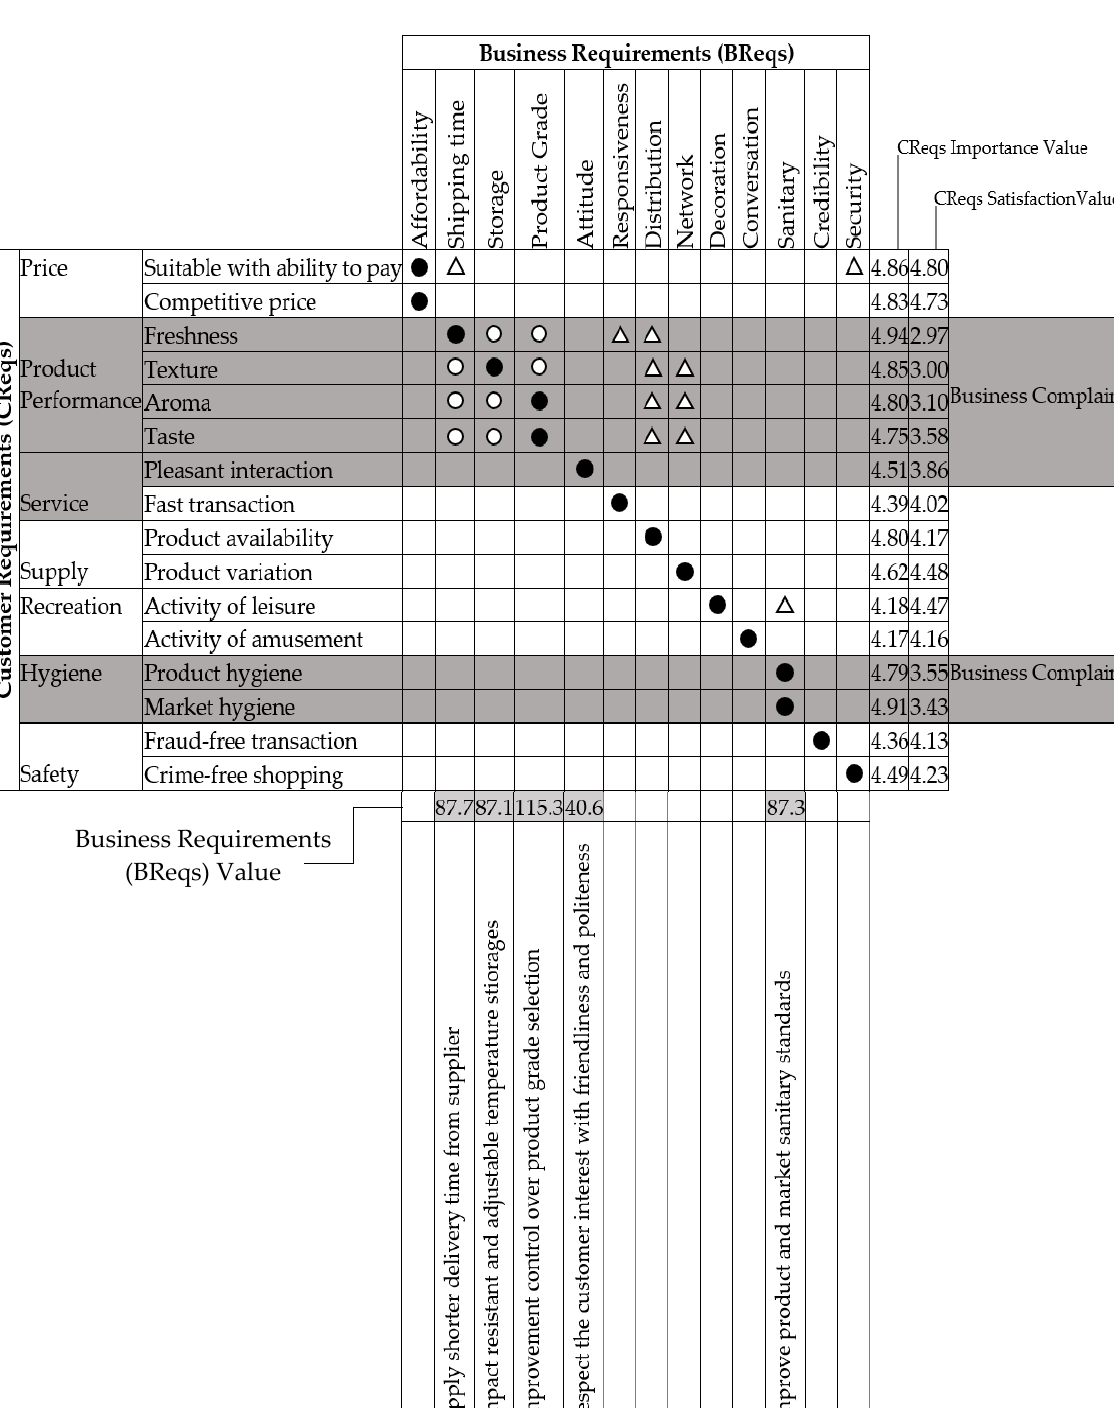
Figure 4. The house of quality matrix of business quality improvement priority